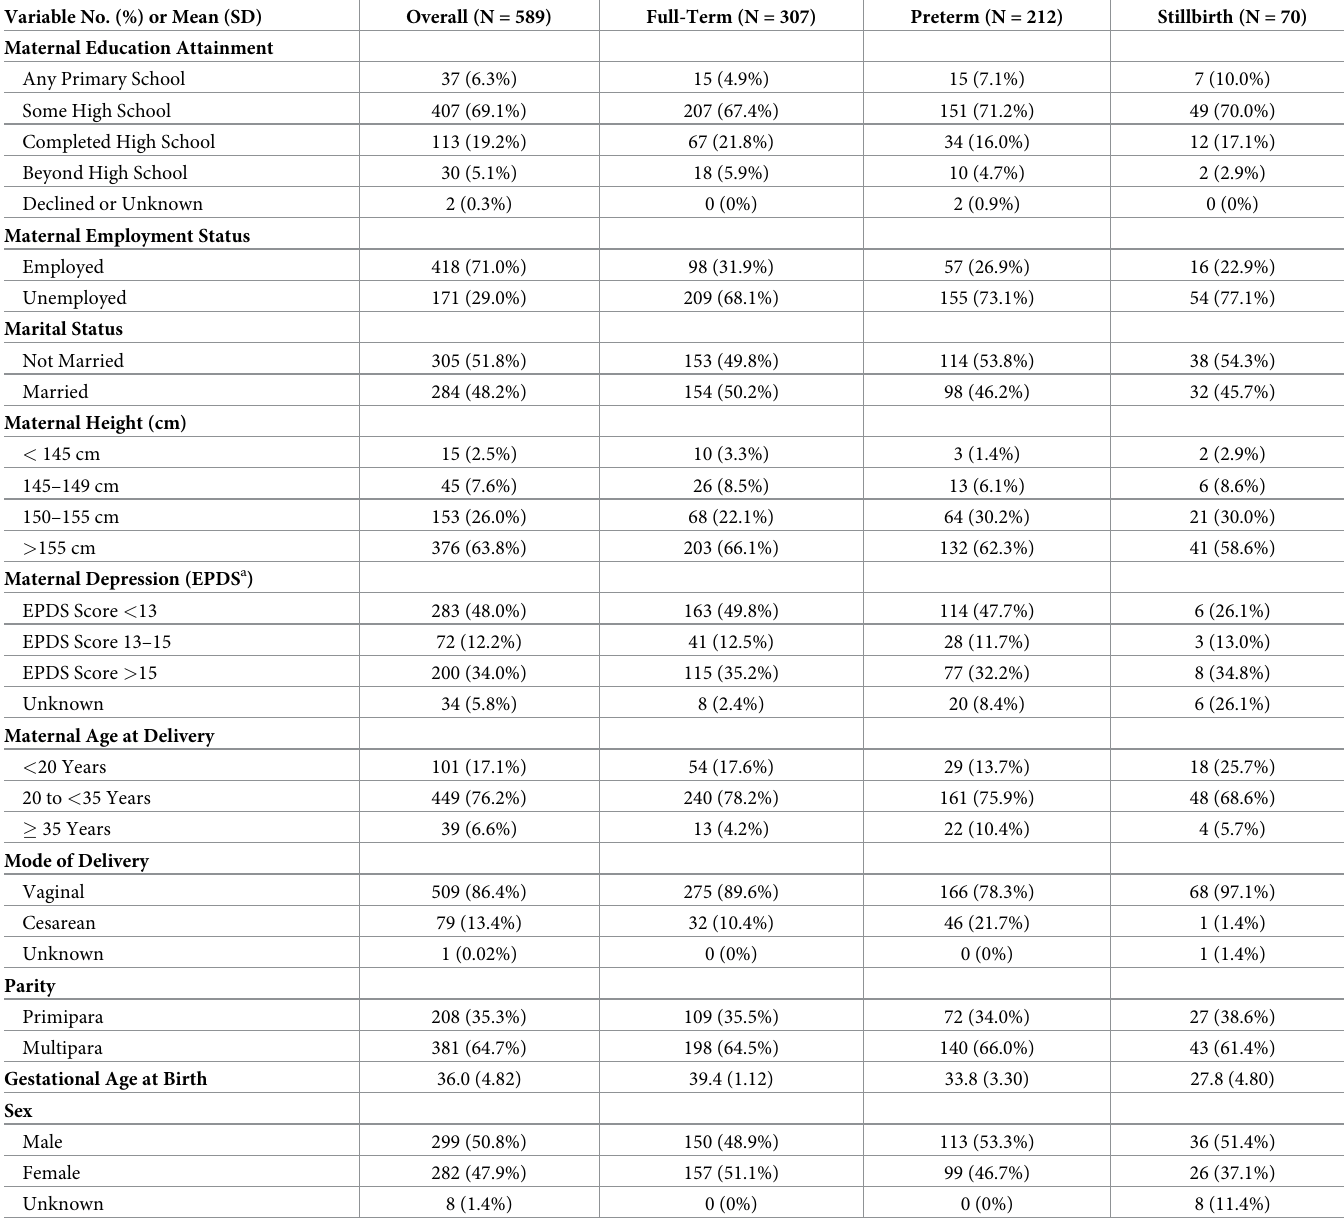
Table 1. Demographic and clinical